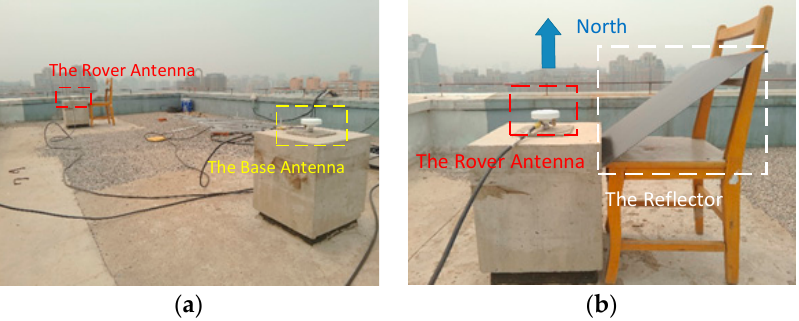
Figure 10. The multipath environment: ( a ) the location of the two antennas; ( b ) the illustration of the reflector.